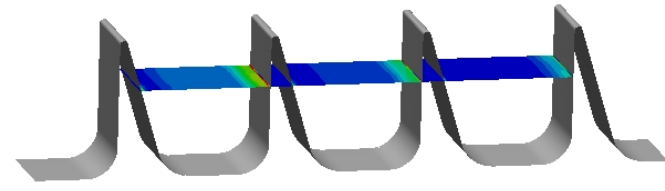
Figure 12. The isosurface where the contour is located.